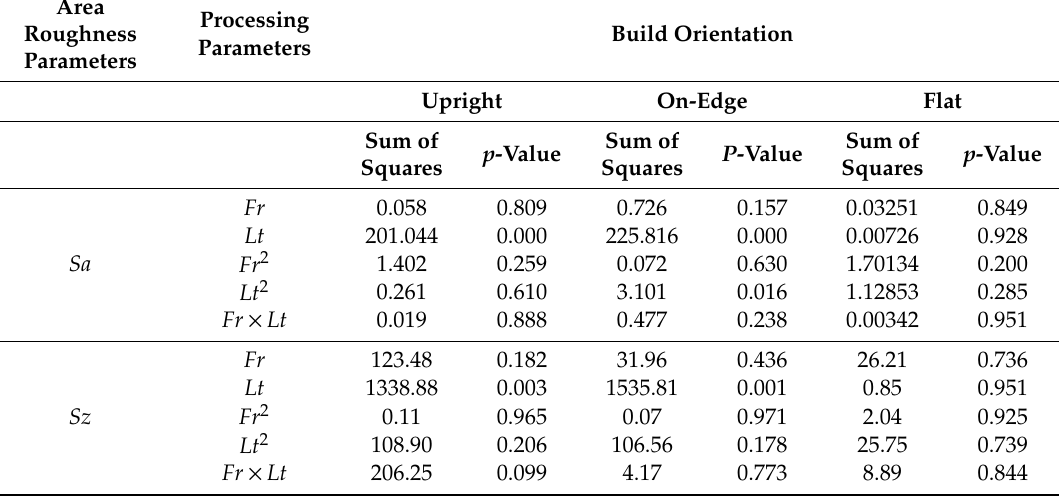
Table 4. ANOVA surface roughness.